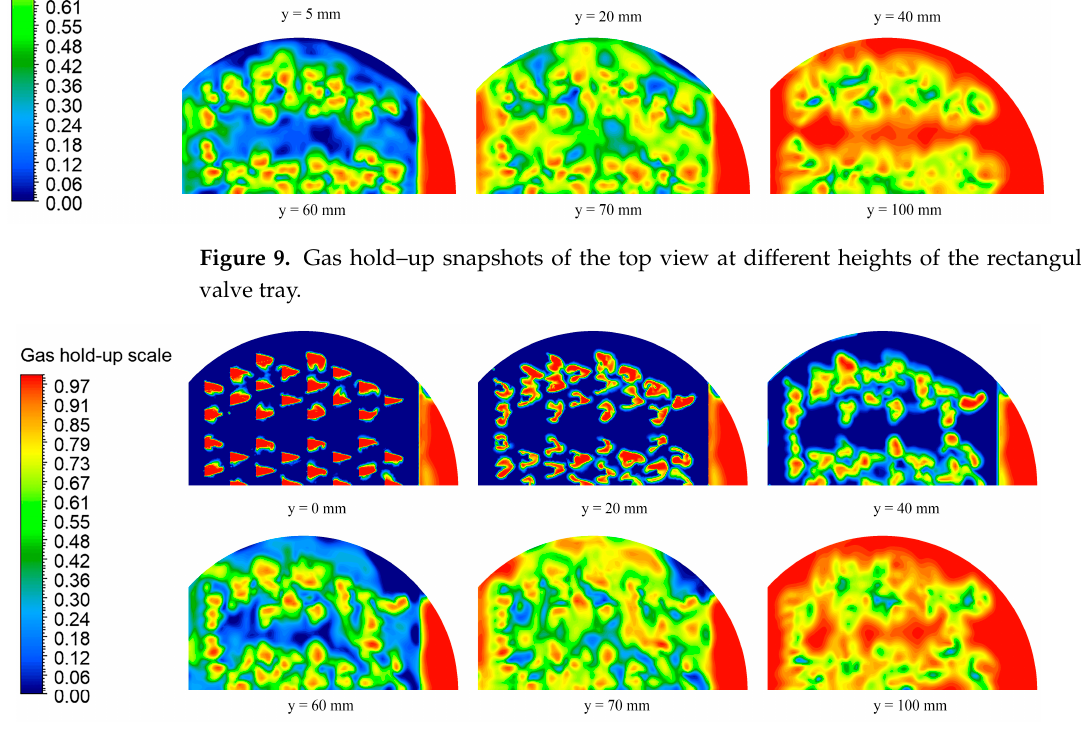
Figure 11. Average gas hold–up at different heights.